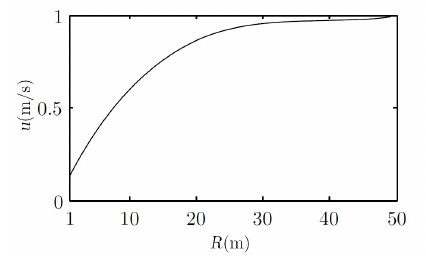
Figure 16. Maximum forward velocity u regarding the radius of